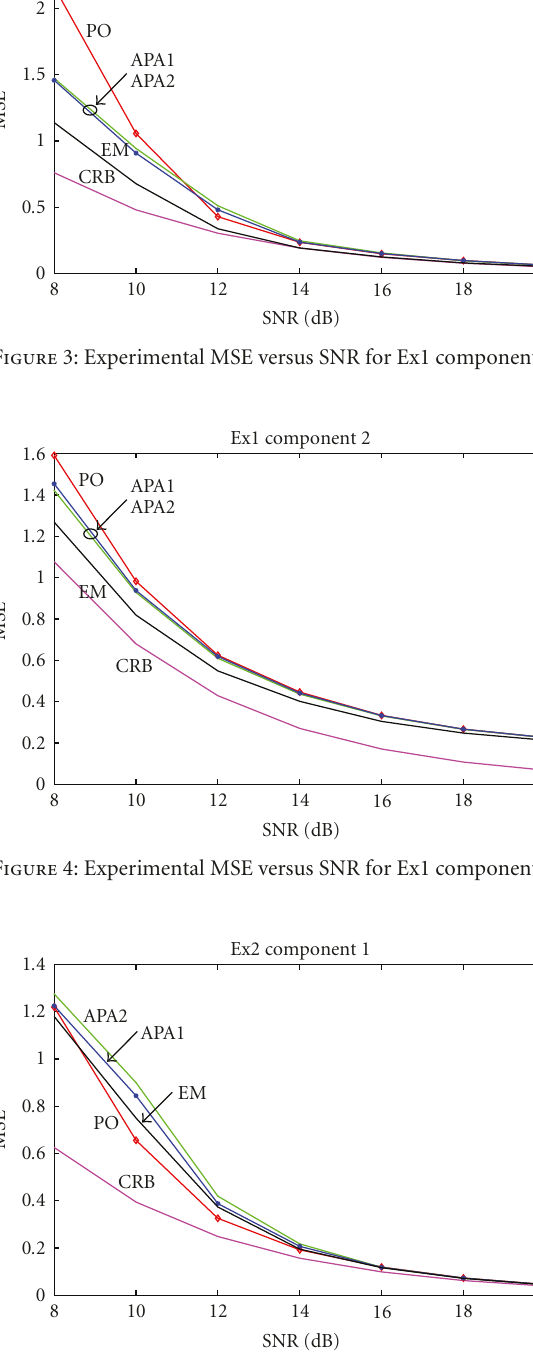
As can be seen from Figures 9 and 10 Increasing SNR to 14 or 20 dB for Ex1 makes the benefit of using APA1 or APA2 apparent. The same advantage was observed for Ex2 and Ex3 also. While at low SNR EM is usually better than the others as the SNR increases, the advantage of EM is